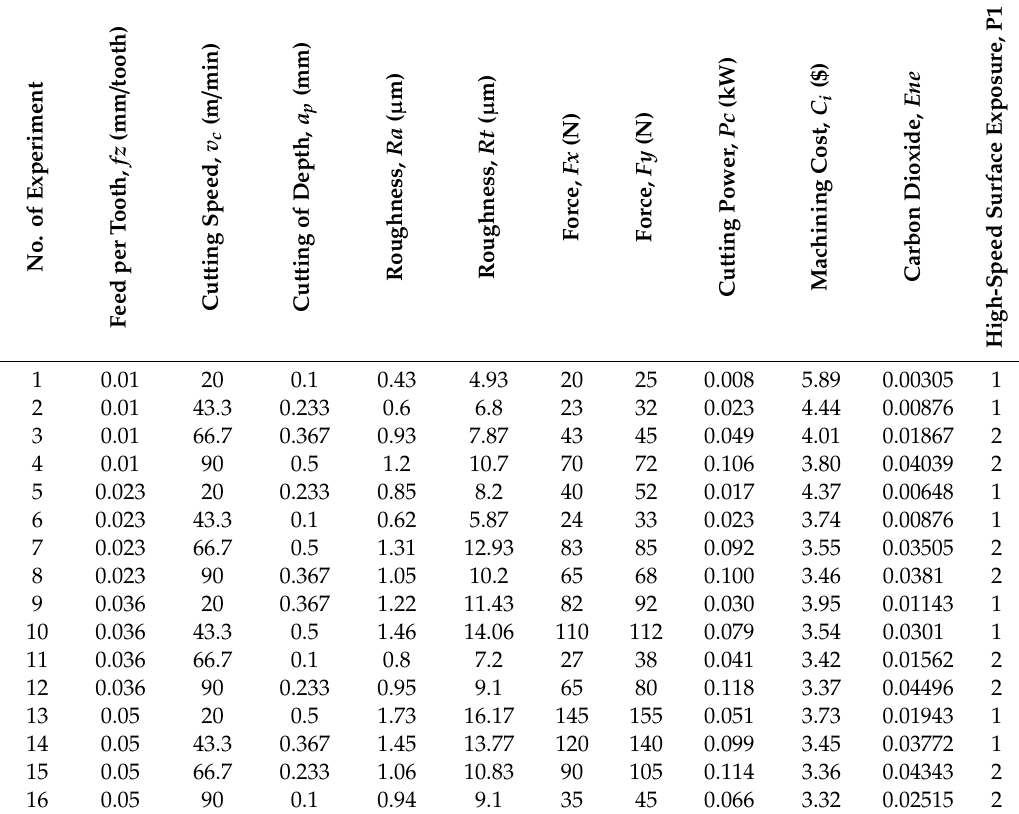
Table 3. Experimental results regarding milling